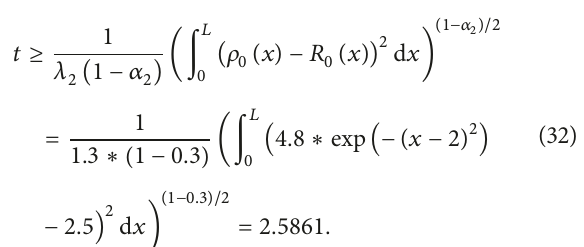
at about 7.1 seconds, and the crowd evacuation process ends.